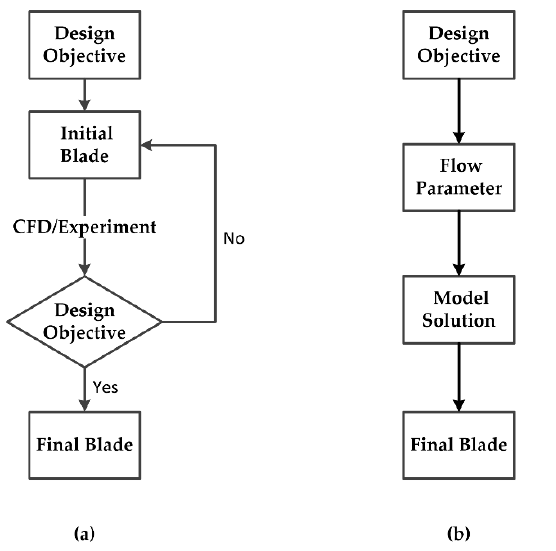
Figure 1. Flowchart of pump-jet design methods: ( a ) direct method and ( b ) inverse method.